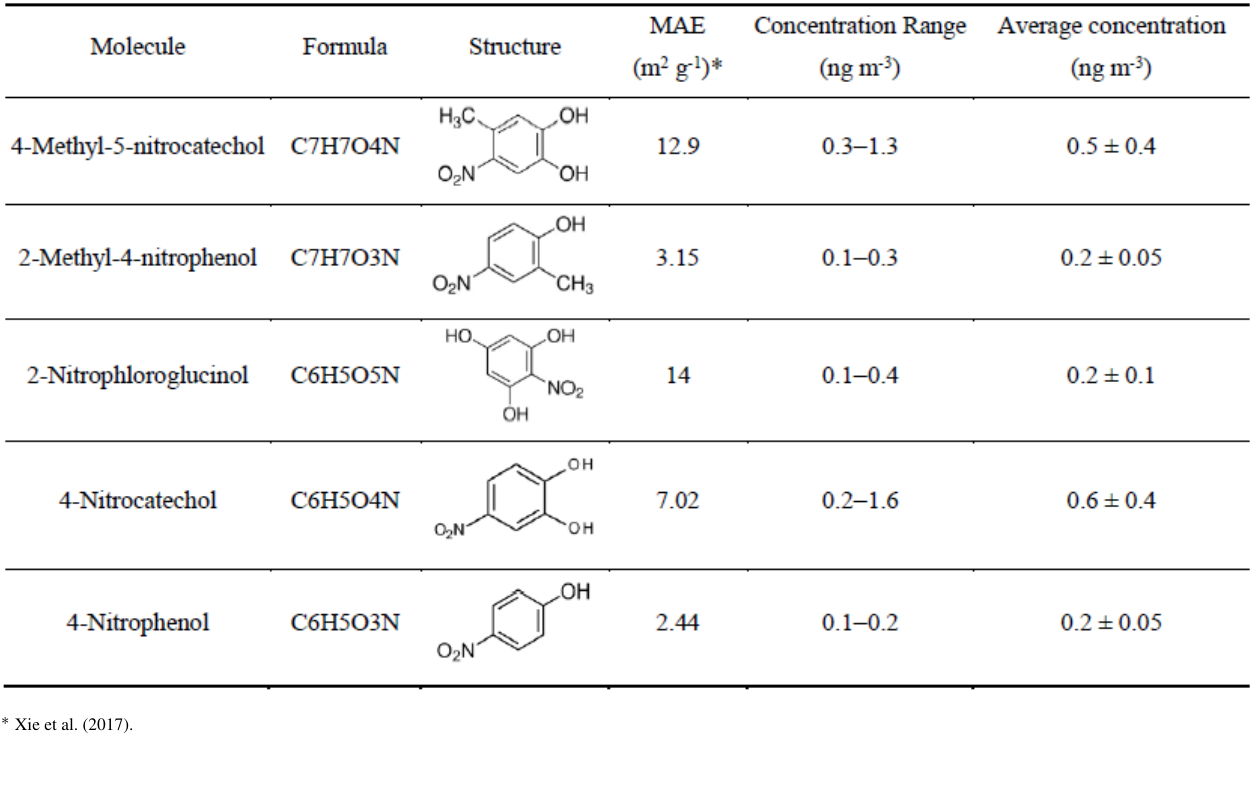
Table 1. Nitro-aromatic compounds detected during the winter in Karlsruhe, including chemical formula, tentative structures, mass absorp-